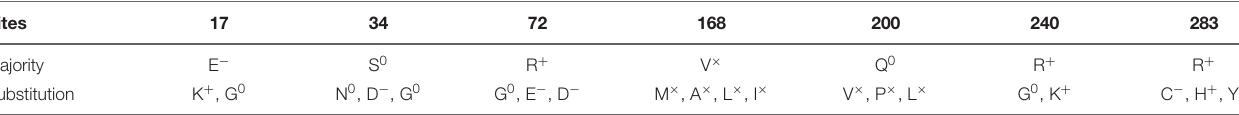
TABLE 4 | Positions and polarities of the positively selected amino acid (AA).